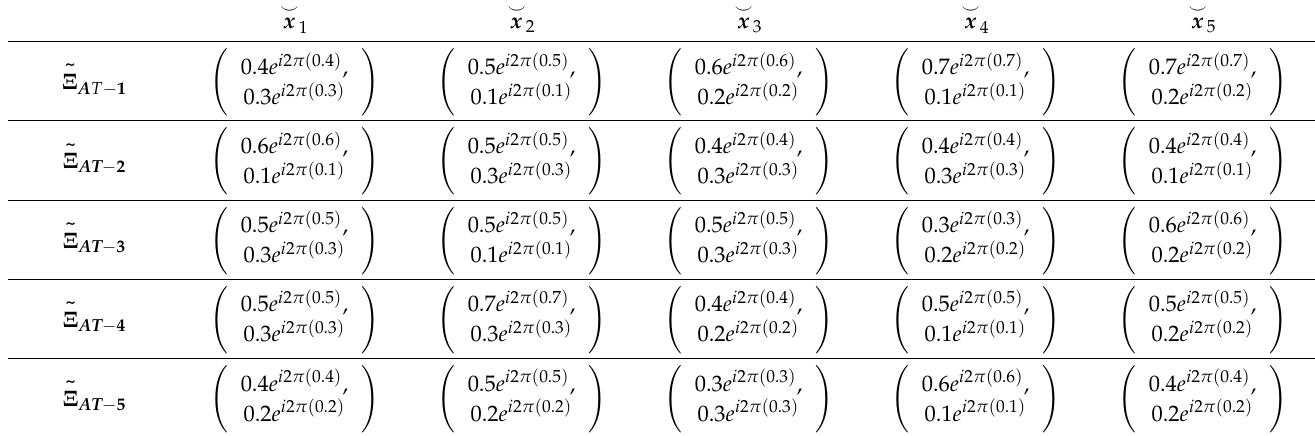
Table 3. Original decision matrix for candidates (cid:101) Ξ CI − 2 .